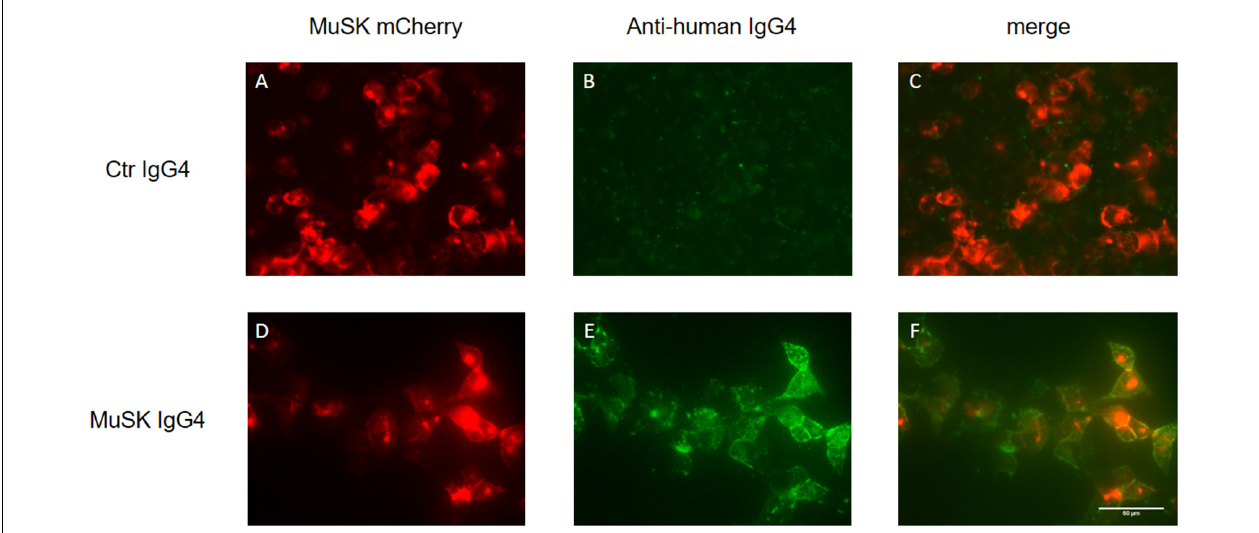
FIGURE 5 | Cell-based assay (CBA) of MuSK IgG4 antibody subclasses. HEK293 cells are transfected with MuSK-mCherry (in red; A,D ) and exposed to MuSK-MG IgG4 antibodies (lower panels) or antibodies purified from a healthy individual as control (upper panel). MuSK antibodies attached to the cell surface are then detected with a secondary fluorescent antibody specific for the IgG subclasses of interest (in green; B,E ). The merged image from healthy control shows the absence of co-localization between MuSK-transfected HEK cells and purified antibodies (C) . Conversely, MuSK IgG4 antibodies give a very strong positive signal (E) with full colocalization with MuSK in the merge picture (F) . Images are taken with an Olympus IX71 fluorescence microscope at 40 × magnifications. Scale bar represents 50 µ m. Unpublished work, similar to Huda et al.